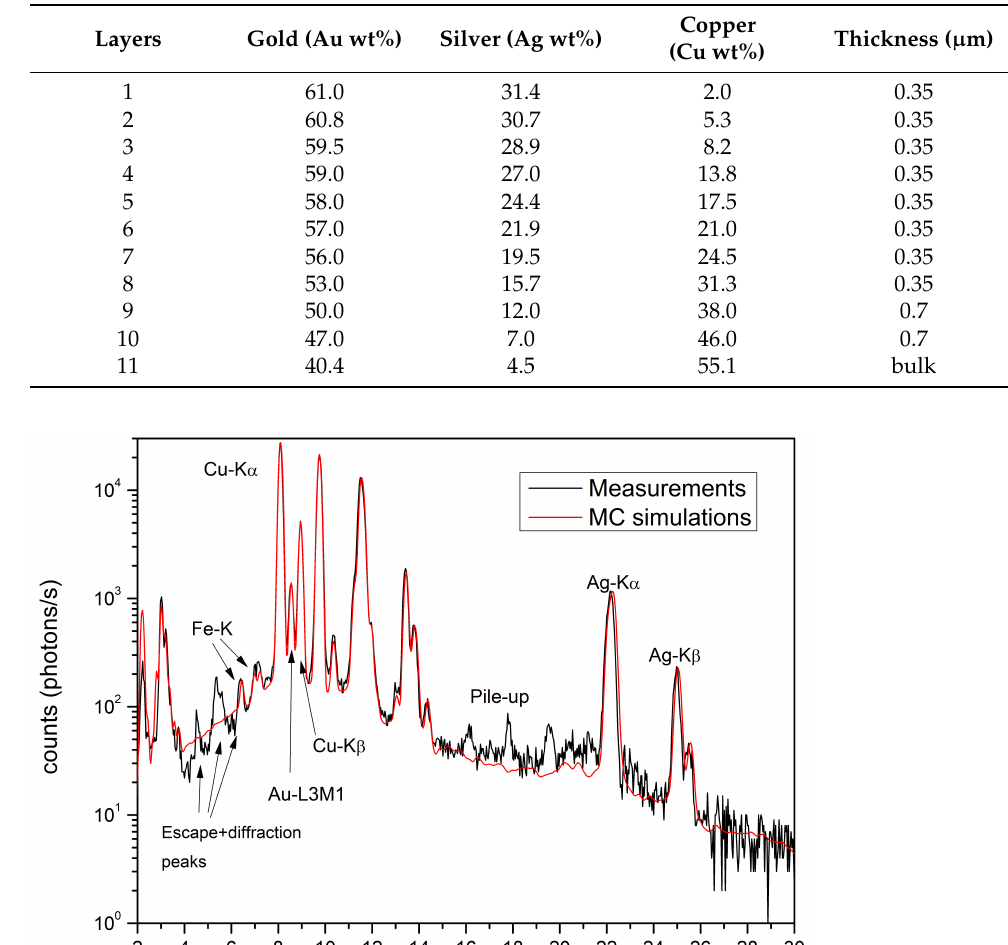
Table 2. Chin protector structure: and composition of each layer. The realtive concentration are in wt%.